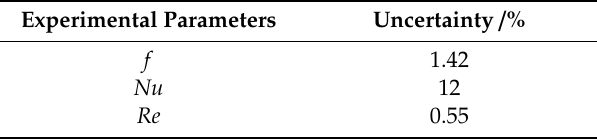
Table 4. Uncertainty of the experimental